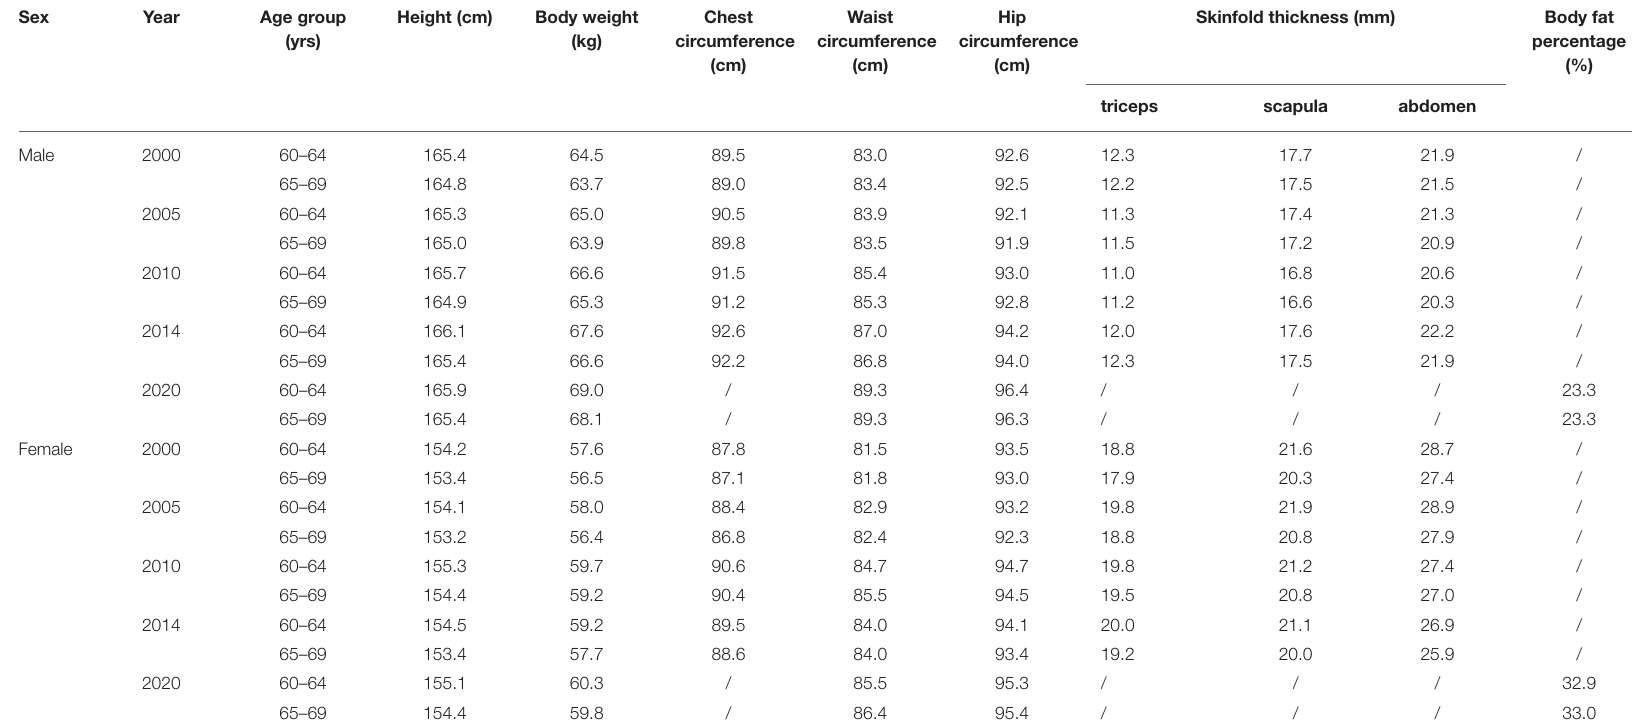
TABLE 2 | Indicators of body morphology average test results in national physical fitness